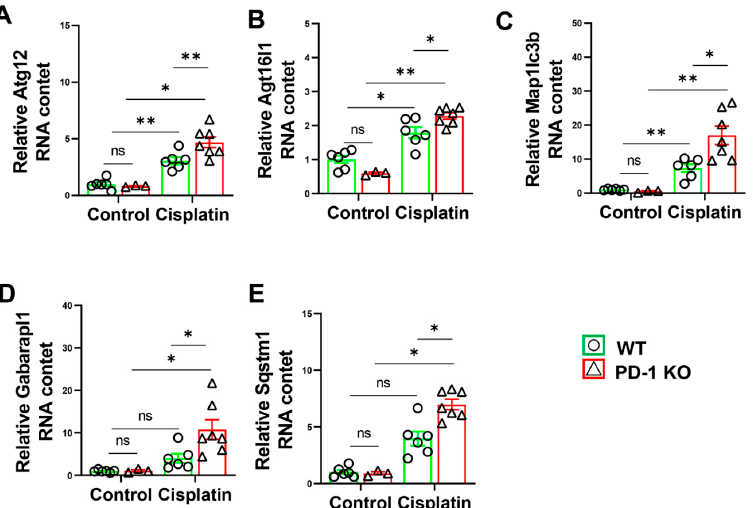
Figure 8. PD-1 − / − exacerbated muscle autophagy in mice after cisplatin treatment. ( A ) The relative mRNA levels of Atg12 in skeletal muscle. ( B ) The relative mRNA levels of Atg16l1 in skeletal muscle. ( C ) The relative mRNA levels of Map1lc3b in skeletal muscle. ( D ) The relative mRNA levels of Gabarapl1 in skeletal muscle. ( E ) The relative mRNA levels of Sqstm1 in skeletal muscle. mRNAs were normalized to GAPDH. n = 5–6 per group. * p < 0.05; ** p < 0.01; ns: non-significant. all values are mean ± SEM.